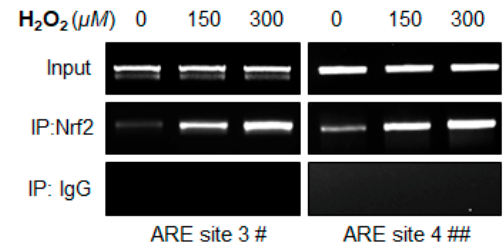
Figure 6. Nrf2 binding was increased to ARE sites present in Klf9 promoter in response to excessive oxidative stress. ( A ) Top panel displaying the presence of four ARE sites in Klf9 promoter and ChIP- qPCR primers consisting of ARE3 and ARE4. ( B ) In vivo DNA binding assay disclosed Nrf2/ARE interaction. hLECs treated with different concentrations of H 2 O 2 (150 and 300 µM) for 3 h. ChIP assay was carried out with Nrf2 and control IgG antibodies. Pulled DNA fragments were subjected to RT-qPCR analysis. DNA fragments present in the immunoprecipitation were amplified with primers that specifically recognized a fragment of Klf9 promoter containing ARE site three and ARE site four as indicated. 10% chromatin was used as input. As a negative control, ChIP with control IgG was used. # and ## denotes primer pairs used for ChIP-RT-PCR.